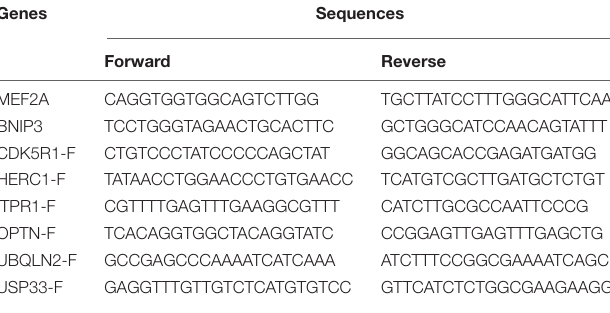
TABLE 3 | The primer sequences of MEF2A and the screened seven